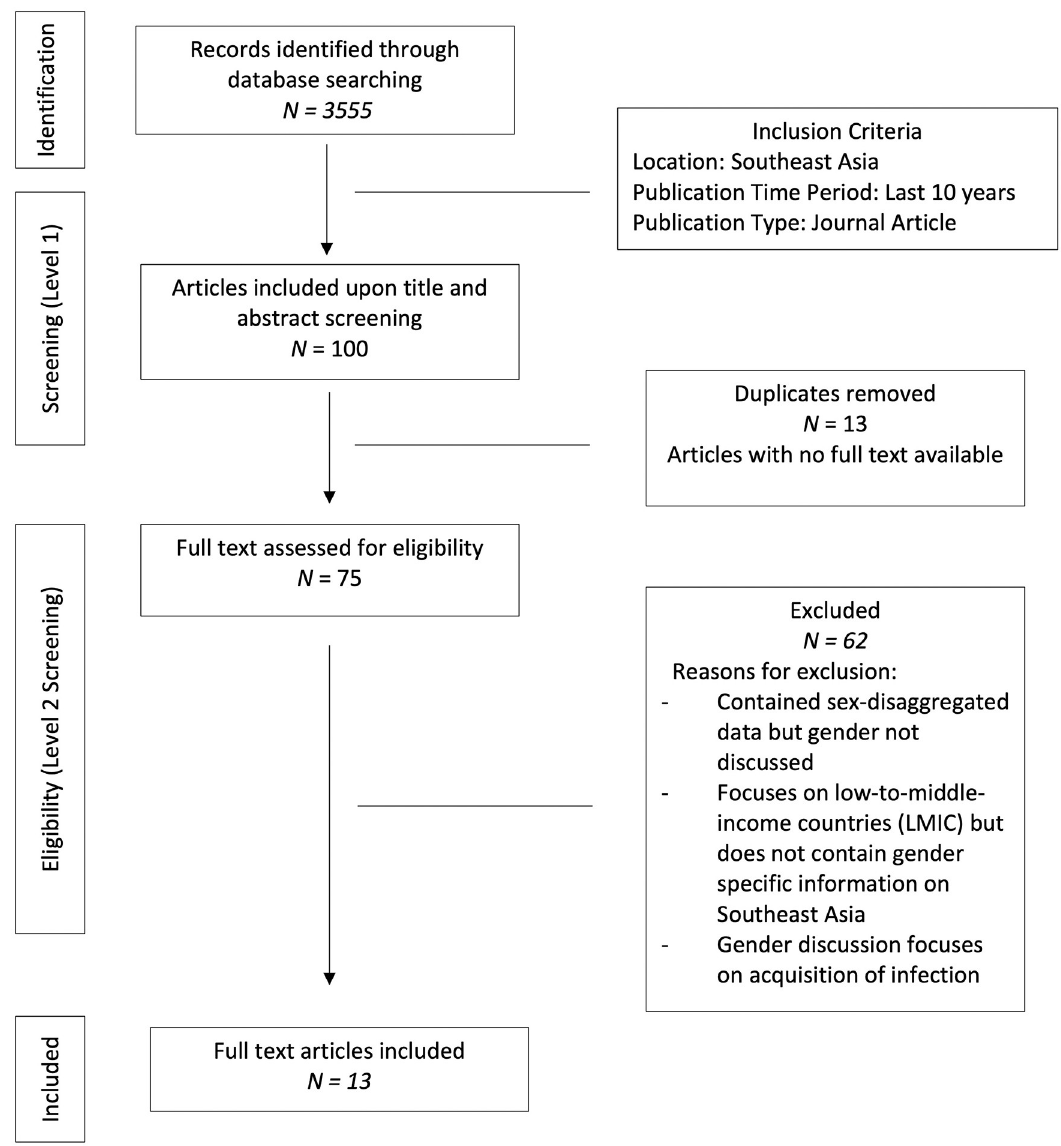
Fig 1. PRISMA-ScR diagram of source selection